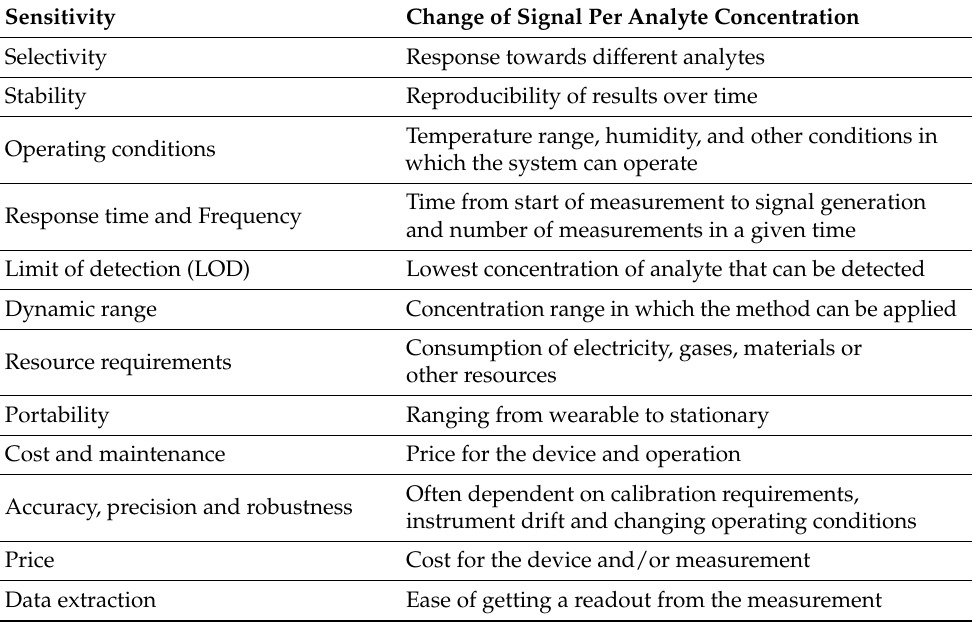
Table 2. Criteria for analytical technique in the characterization of